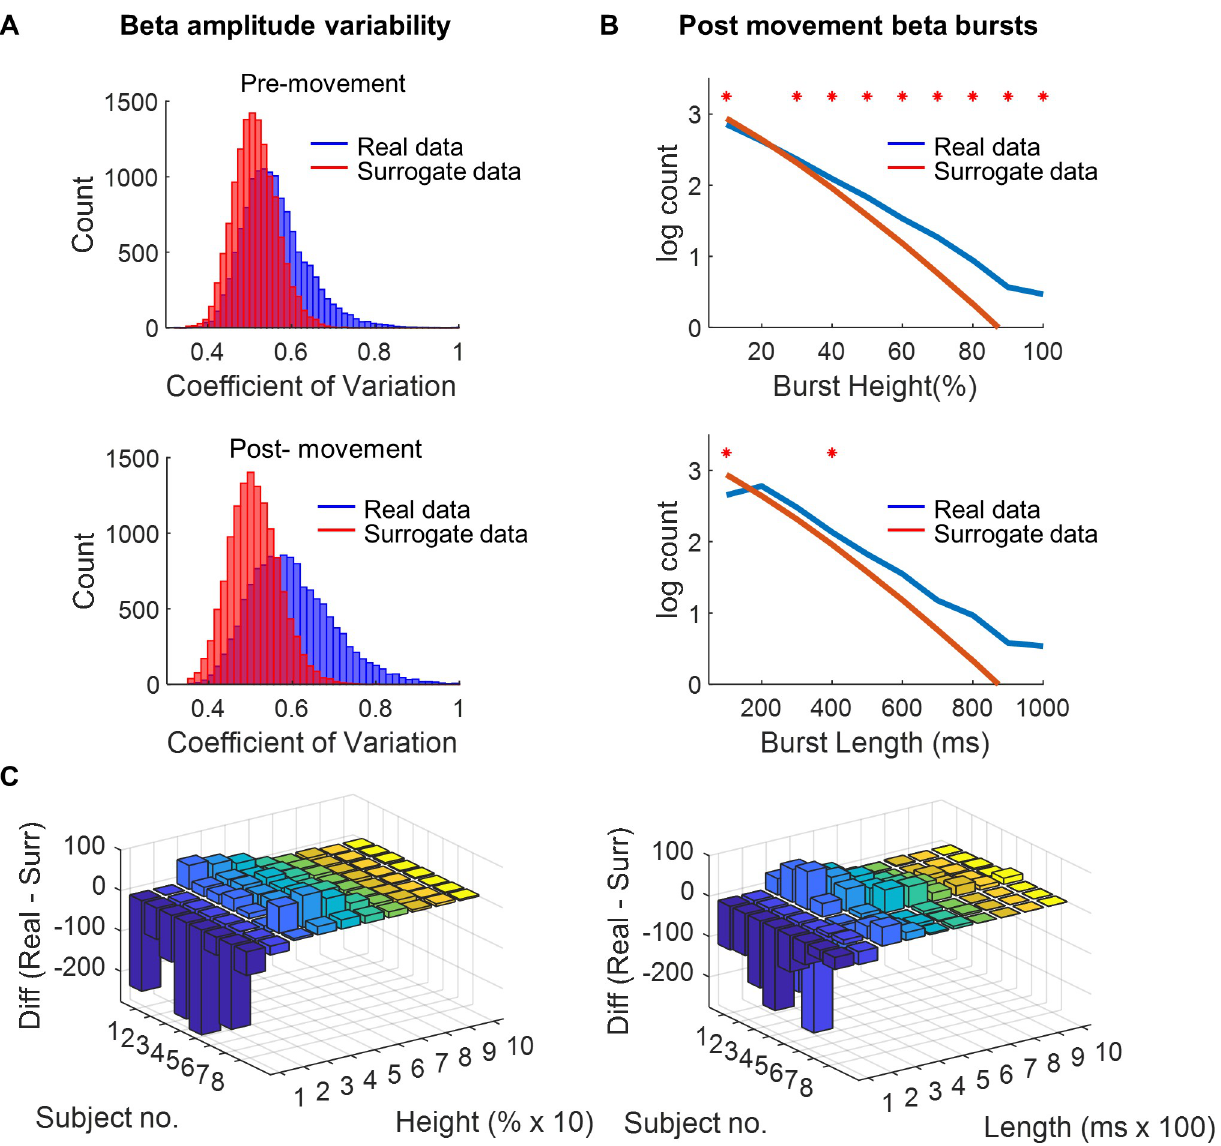
Fig 3. Comparison of movement-related beta amplitude changes and phase-randomised surrogate data. (A) Beta amplitude variability is quantified by the CV of beta amplitude for pre- and post-movement periods, respectively. The CV in the observed data is significantly larger (right shift in histogram) in both the pre- and post-movement periods when compared with a spectrally matched surrogate dataset. (B) Group-level line histogram of the log10 mean burst counts for different heights (B: top) and lengths (B: bottom) for real versus surrogate post-movement data ( � p < 0.05, false discovery rate [FDR] corrected). (C) Difference in burst height and length counts shown for each subject compared with bursts from a surrogate phase-randomised dataset (burst height/length real data minus burst height/length surrogate data). This demonstrates a relative reduction in the number of the smallest and shortest bursts in the real compared with surrogate data, with an increase in larger and mid-length bursts (same analysis shown for pre-movement data in S2 Fig). The underlying data can be found at https://osf.io/eu6nx/. CV, coefficient of